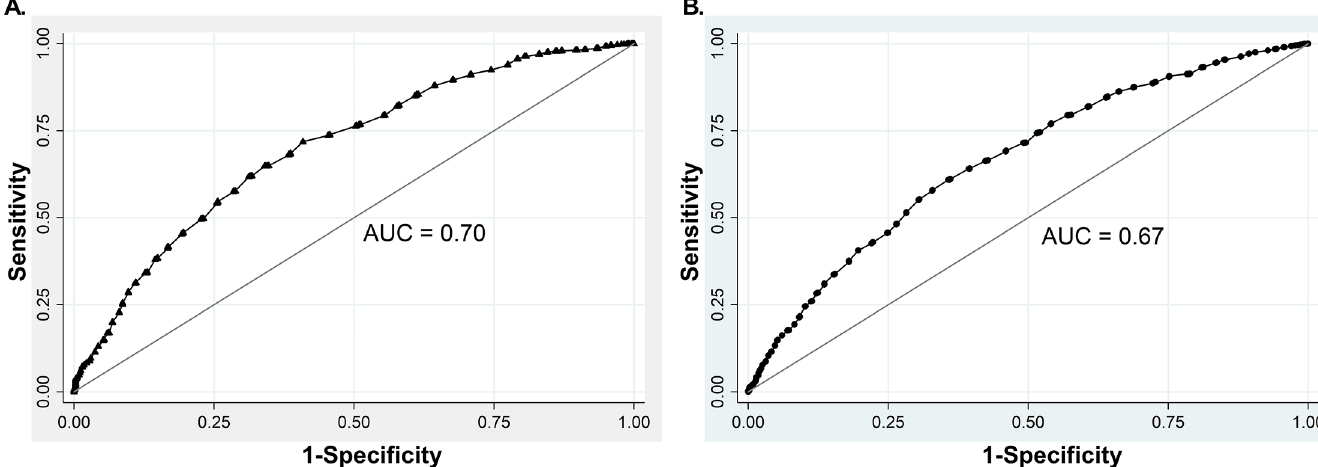
Fig 1. ROC analysis for WC and CVRF in the whole sample defined by the presence of at least one of the following risk factors: Systolic or diastolic hypertension, total hypercholesterolemia, LDL hypercholesterolemia, decreased HDL-C hypertriglyceridemia, impaired fasting glucose or diabetes mellitus in men (A) and women